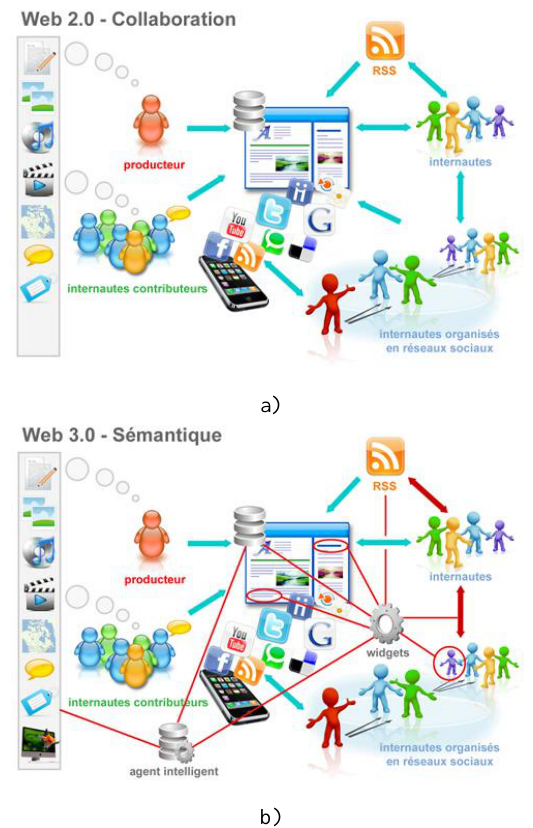
Figure 2. Visual comparison of Web 2.0 and Web